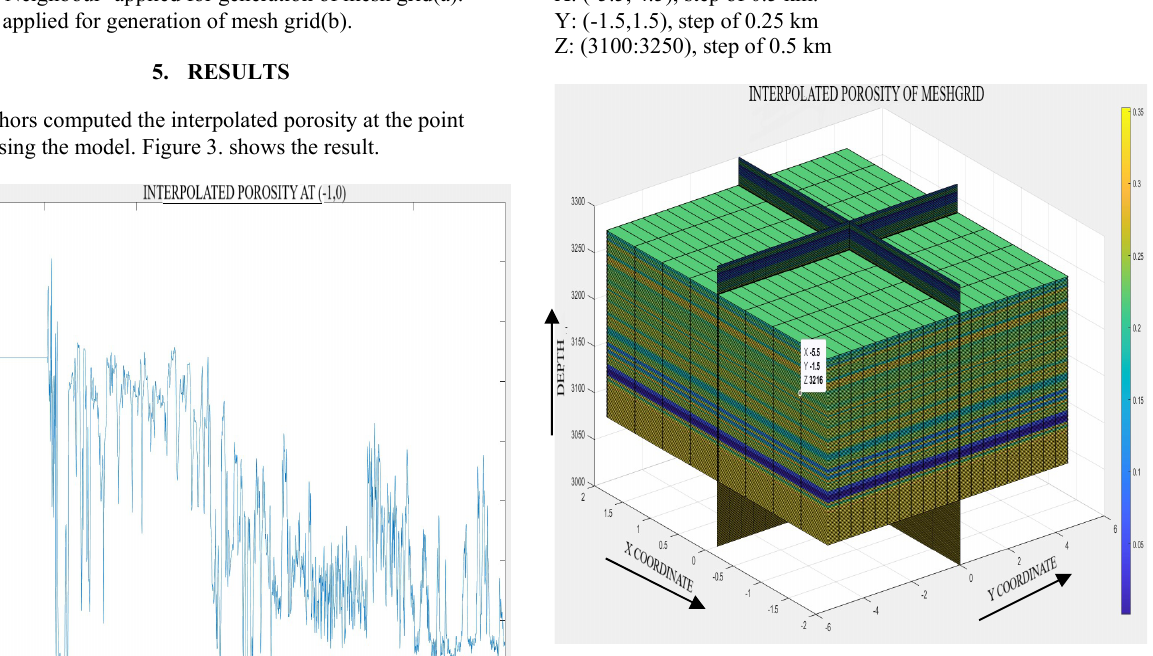
Figure 5. Reservoir porosity (displayed on colour-bar) of interpolated mesh-grid(a) whose coordinates are mentioned above this figure. Figure 6. and 7. show how a curve is visualised in the reservoir. The grid spacing was controlled by altering the spaces or the interval between depths. Owing to computational limitation the curve has covered a small gap in the reservoir. The difference between the two curves is the grid spacing. Figure 7. is more refined. Figure 6. has the following specifications: X, Y: (-1.5,1.5), step of 0.2 km